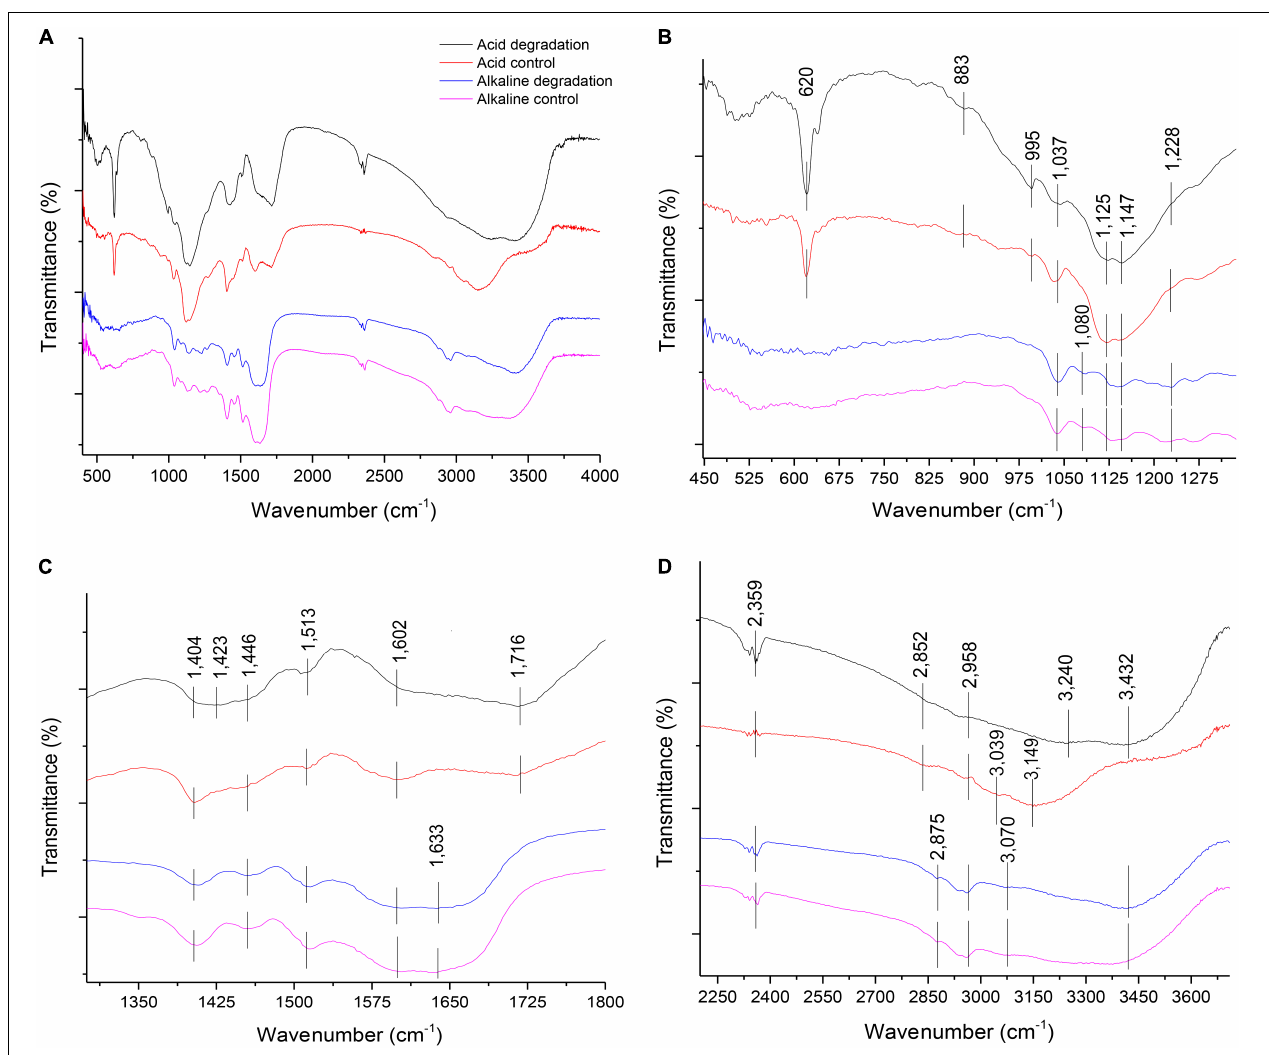
FIGURE 5 | (A) Overall FTIR spectra of acid and alkaline biodegradation of lignin and controls; (B) spectra from wave numbers 450–1,300 cm − 1 ; (C) 1,300– 1,800 cm − 1 ; (D) 2,250–3,700 cm − 1